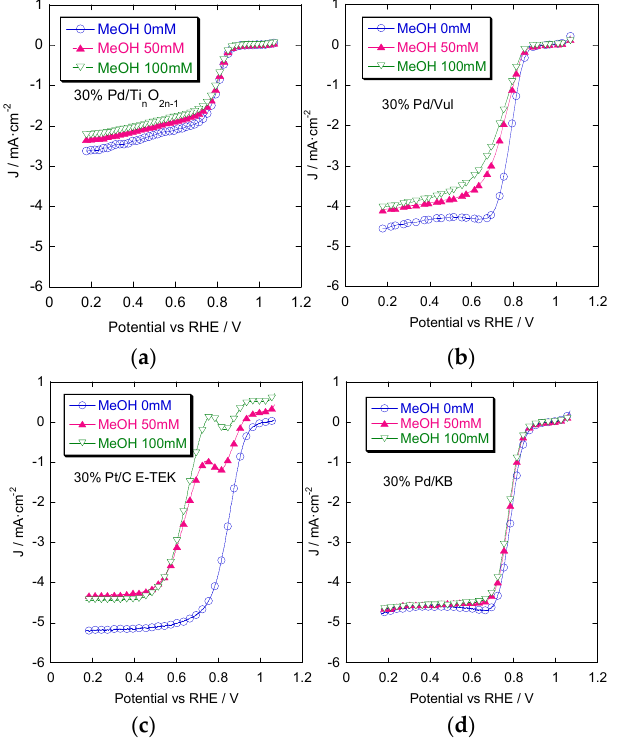
Figure 3. Linear sweep voltammetry of oxygen reduction at different MeOH concentrations (0; 50; 100 mM) for 30% Pt/C E-TEK ( a ); 30% Pd/KB ( b ); 30% Pd/Ti n O 2 n –1 ( c ) and 30% Pd/Vul ( d ). Scan rate 5 mV·s − 1 ; 1000 rpm; room temperature and 50 μ g·cm − 2 of Pd or Pt loading.